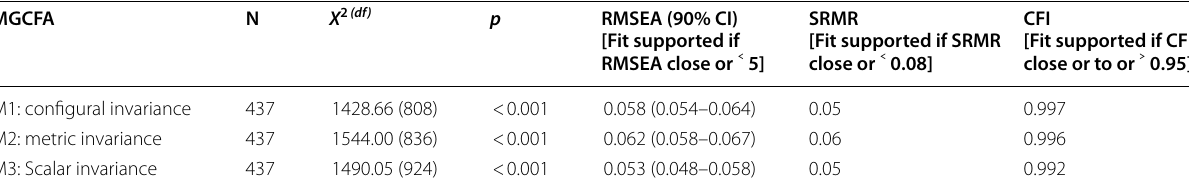
Table 4 Multiple group confirmatory factor analysis of model